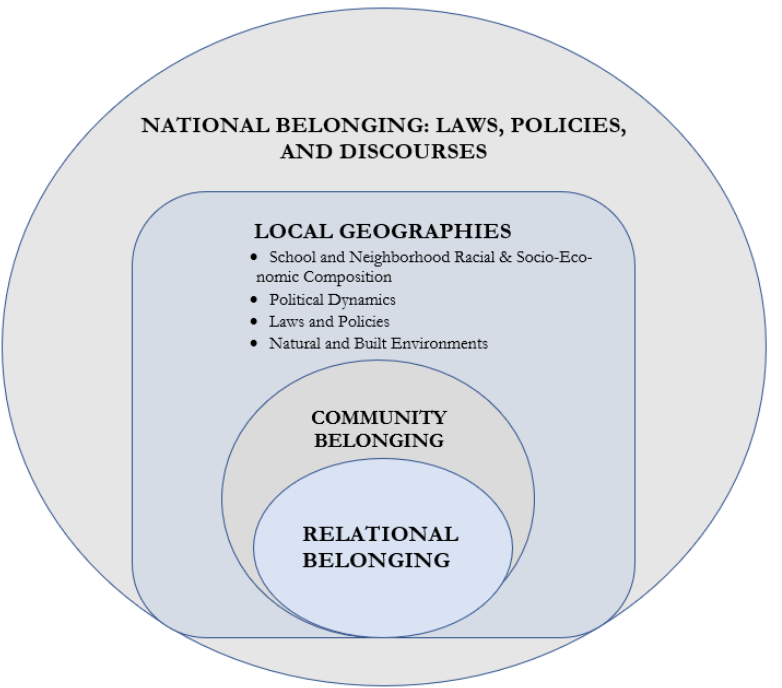
Figure 1. Spaces of Belonging for Immigrant Youth.